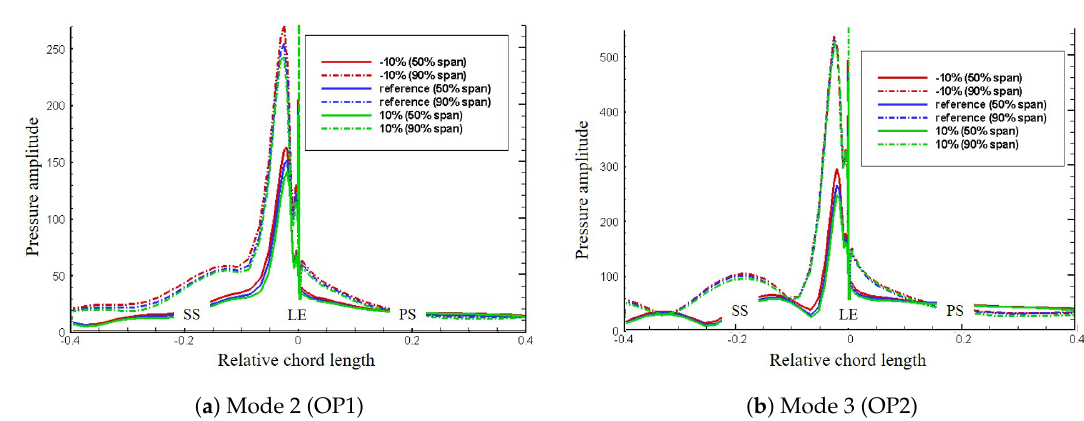
Figure 19. Distribution of the unsteady pressure in relative chord length with different axial gap